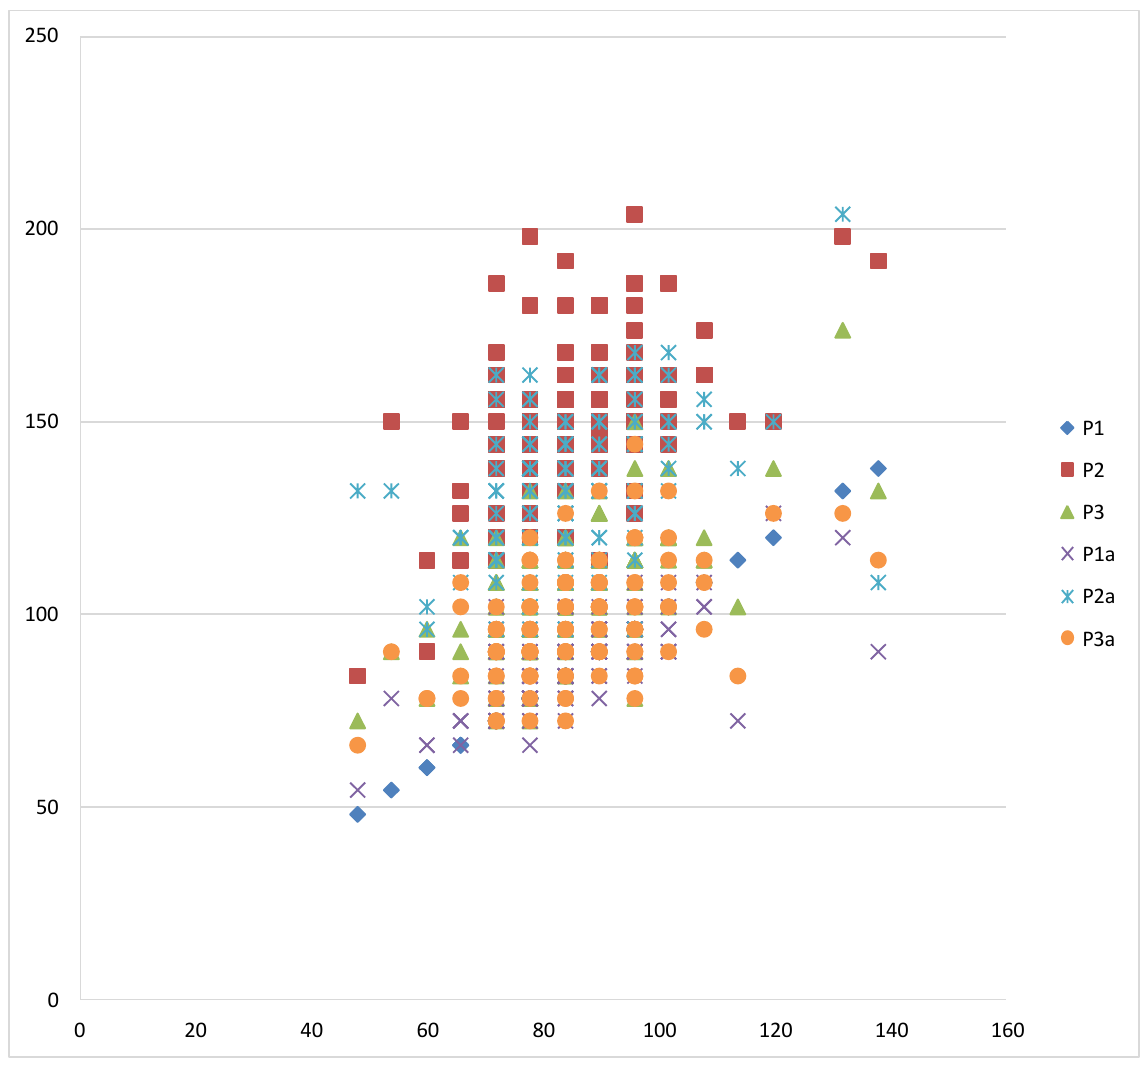
Fig.2. Correlation field of heart beats rate registration results in commonly accepted Ruffier’s test P1, P2, P3) and in adapted version (P1a, P2a,